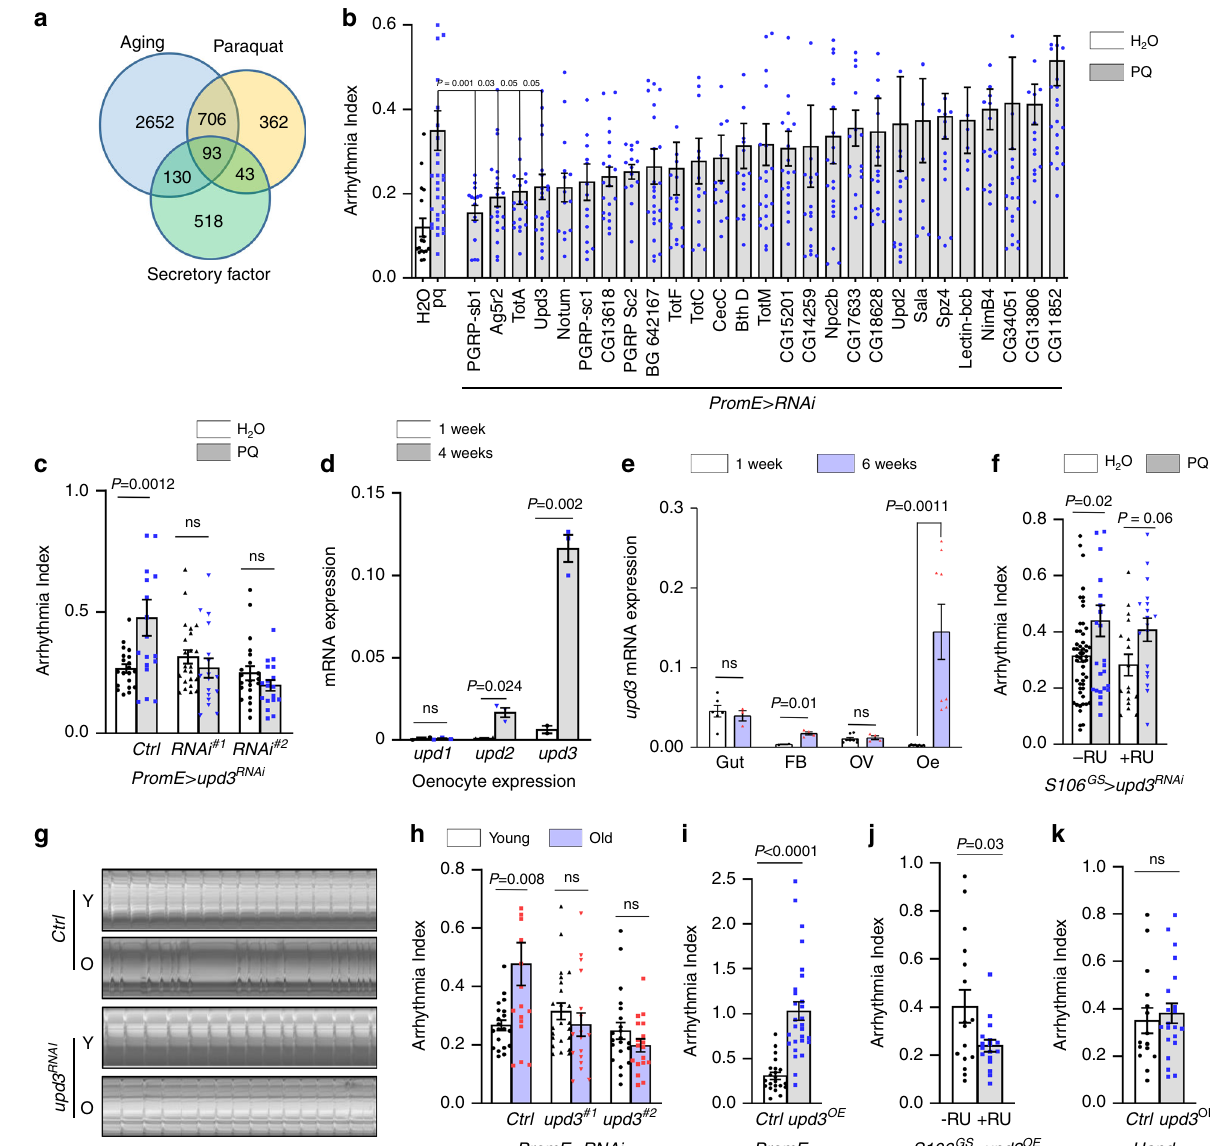
Fig. 2 Pro-in fl ammatory upd3 produced from oenocytes mediates arrhythmia. a Venn diagram showing the number of the predicted secretory proteins that are differentially expressed ( ≥ 2-fold, FDR < 0.05) under aging and paraquat treatment. Aging and paraquat RNA-Seq data were from our previous studies. Fly ages: 10-day-old vs. 30-day-old. b Genetic screening on 27 candidate genes for their role in paraquat-induced arrhythmia. WT: Wild-type ( attP2 or attP40 RNAi control lines). For statistical numbers, refer to the Methods section. c PQ-induced arrhythmia measured by SOHA for two independent upd3 RNAi lines under oenocyte-speci fi c GeneSwitch driver ( PromE GS -Gal4 ). Ctrl genotype is PromE > attP40 . (n left-right = 20, 18, 23, 17, 22, 18 fl ies). d Relative mRNA expression of upd1, upd2 and upd3 from isolated oenocytes at ages of 1 week or 4 weeks. N = 3 biologically independent samples. e Relative mRNA expression of upd3 in different tissues dissected from young (1 week) and old (6 weeks) female fl ies. FB: fat body, OV: ovary, oe: oenocytes. N = 4 biological samples, results pooled from 2 independent experiments. f PQ-induced arrhythmia measured by SOHA for upd3 RNAi under fat body/gut- speci fi c GeneSwitch driver, (n left-right = 52, 27, 17, 18 fl ies). g Representative M-mode traces of wild-type and oenocyte-speci fi c upd3 knockdown fl ies at young and old ages. h Arrhythmia index of wild-type and oenocyte-speci fi c upd3 knockdown fl ies. Two independent RNAi lines used. Ctrl genotype is PromE > attP40 , (n = 14, 17, 19, 20, 18, 19 fl ies). i Arrhythmia index for fl ies with ectopic upd3 expression (UAS-upd3-GFP) speci fi cally in oenocytes. left-right Flies are 1-week-old. Ctrl genotype is PromE > attP40 (n left-right = 22, 28 fl ies). j Arrhythmia index of fl ies overexpressing upd3 in fat body and gut (S106GS- Gal4), n left-right = 16, 17 fl ies. k Arrhythmia index of fl ies overexpressing upd3 in the heart (Hand-Gal4), n left-right = 16, 21 fl ies. Data are represented as mean ± SEM. P values are calculated using two-tailed unpaired t-test ( i – k ), one-way ANOVA ( b ), or two-way ANOVA ( c – f , h ) followed by Holm-Sidak multiple comparisons. ns: not signi fi